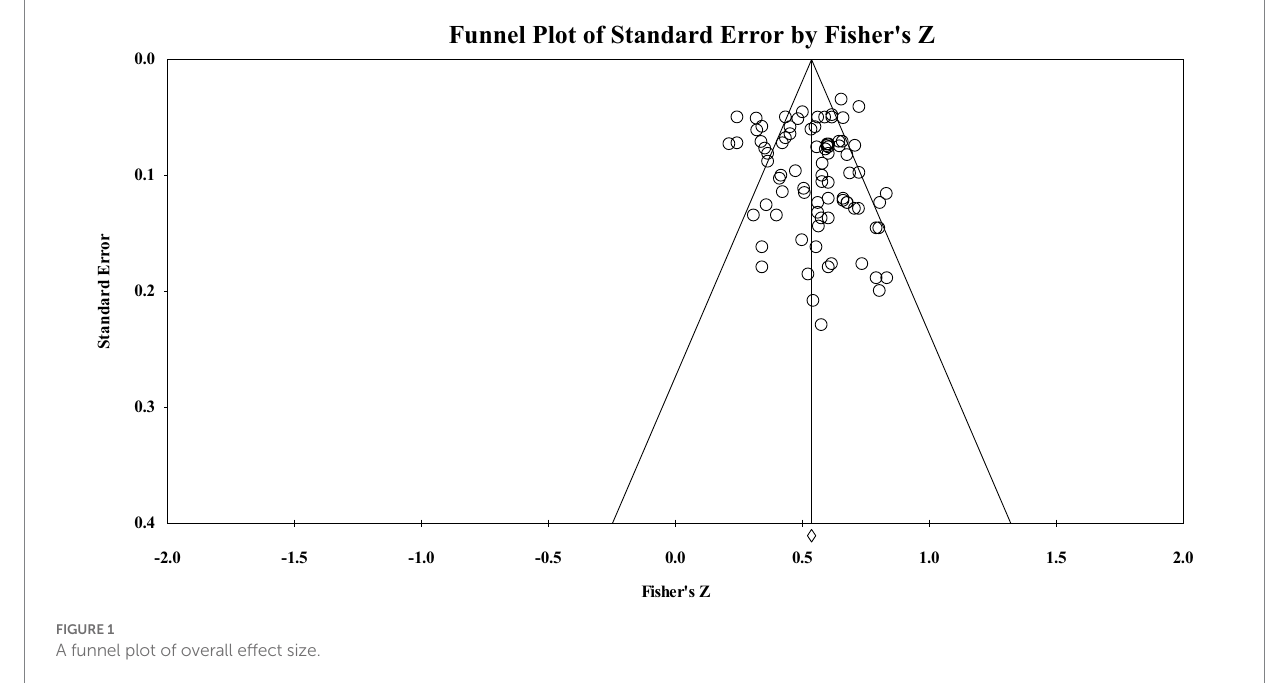
FIGURE 1 A funnel plot of overall effect